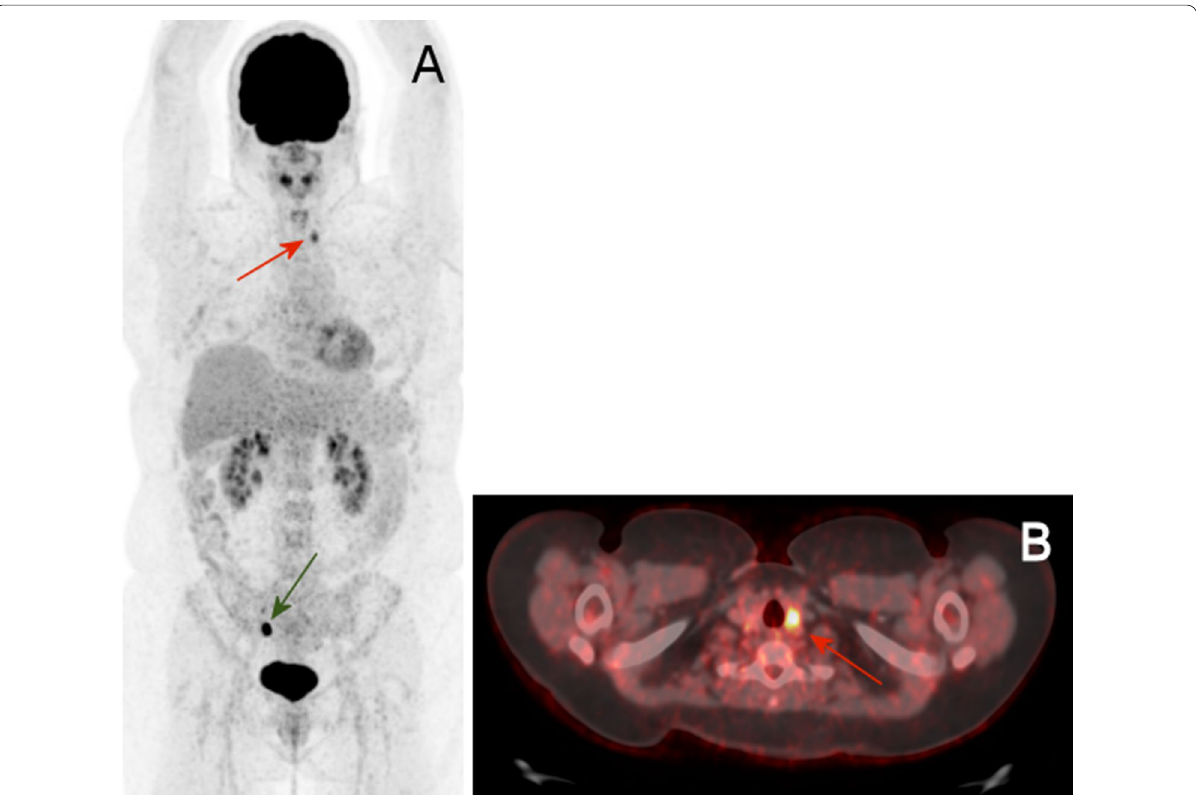
Fig. 4 [ 18 F]FDG‑PET/CT in a 40‑year‑old woman with previous breast cancer who underwent [ 18 F]FDG‑PET/CT due to bone pain. [ 18 F]FDG‑PET/ CT showed incidental focal [ 18 F]FDG‑uptake in the thyroid gland that revealed papillary thyroid carcinoma stage T2N1M0. A: Maximum intensity projection and B: axial section of the neck region of [ 18 F]FDG‑PET/CT. The red arrows show the incidental focal uptake in the left thyroid gland, and the green arrow shows incidental benign physiologic uptake in the right